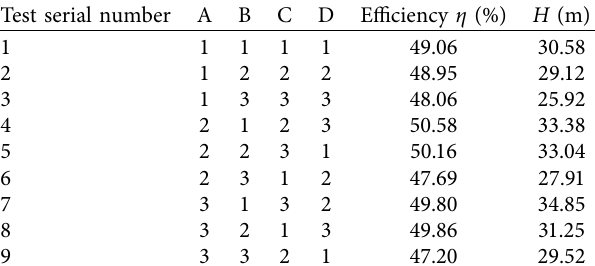
Table 6: Test arrangements and